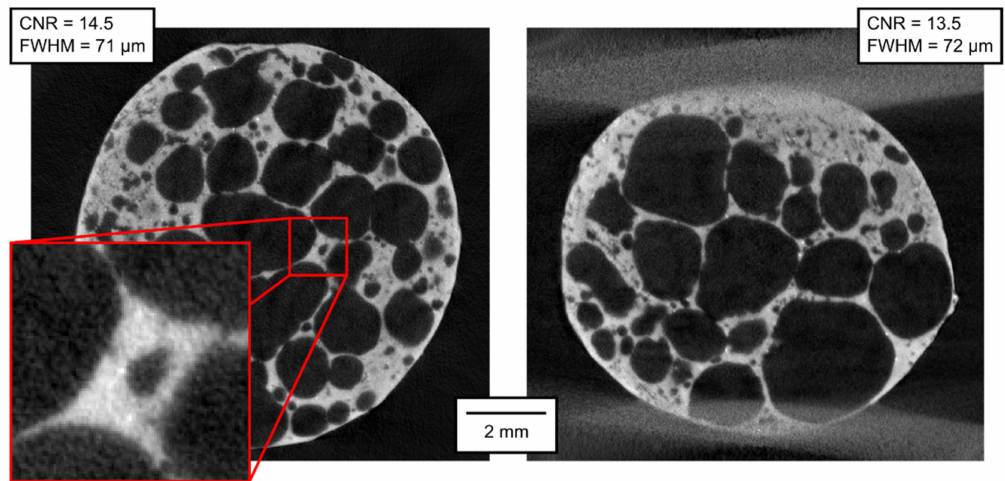
Figure 9. Transversal and lateral central section of the 3D reconstructed volume, Mode C.